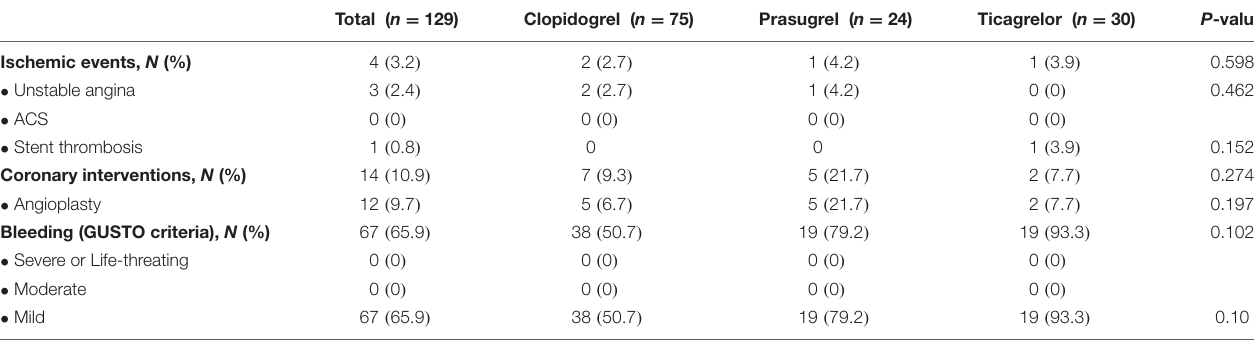
TABLE 3 | Adverse events at 6 months.